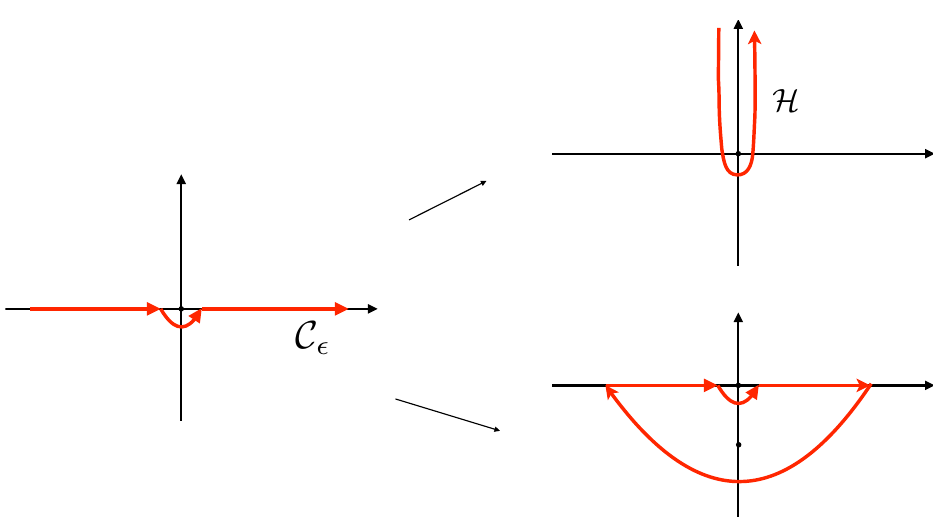
Figure 16 . The contour of integration in (4.6) is first deformed to C (cid:15) , which is then further deformed in two different ways for the different terms in the